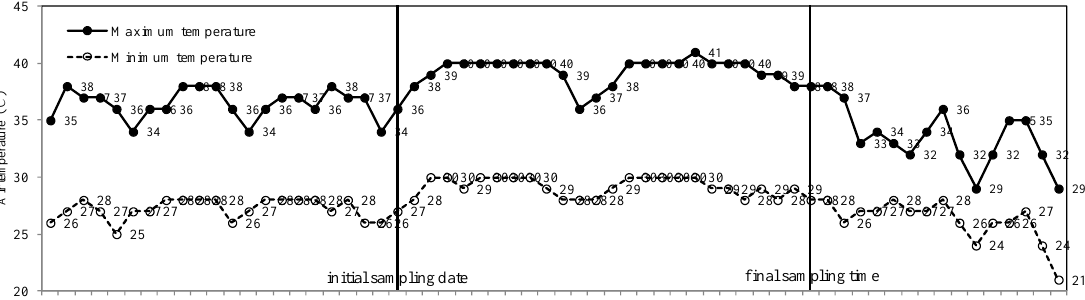
Figure 1. Air temperature chart of Hangzhou during July and August in 2013.